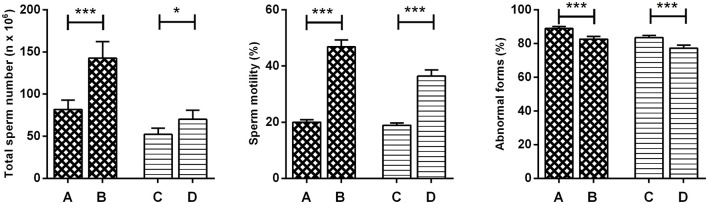
Variation in mean semen parameters of 103 patients, baseline and post-treatment, divided in the sub-group with DFI < 17% (48 patients) and DFI ≥ 17% (55 patients) (Wilcoxon signed-rank test). (A) Baseline DFI < 17%, (B) post treatment DFI < 17%, (C) baseline DFI ≥ 17%, (D) post treatment DFI ≥ 17%. *P < 0.05 ***P < 0.001.